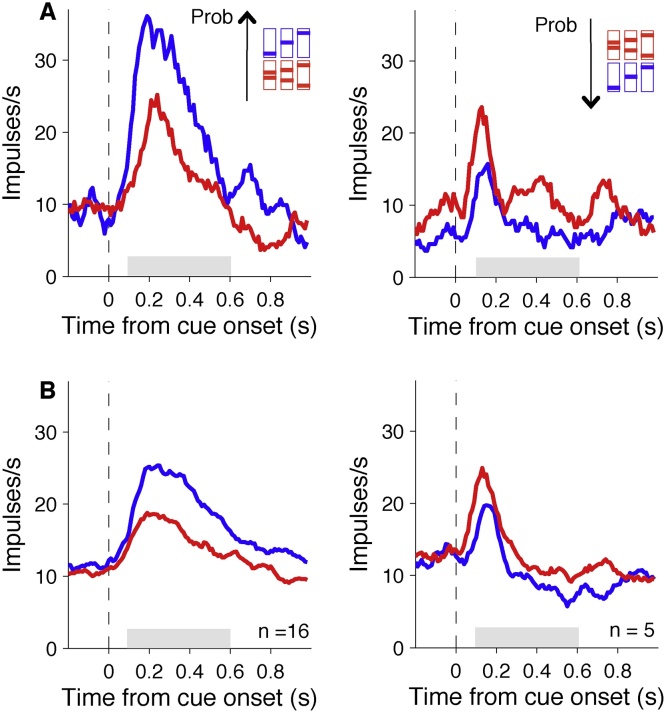
Orbitofrontal neurons code reward probability. (A) Smoothed histograms showing examples of individual neurons coding reward probability following cue onset with positive slope (left) or negative slope (right). The shaded area shows the time window used for analysis. (B) Smoothed histograms showing population responses from all neurons with statistically significant correlation coefficients for reward probability during the shaded period. Colour scheme the same as Fig. 2.